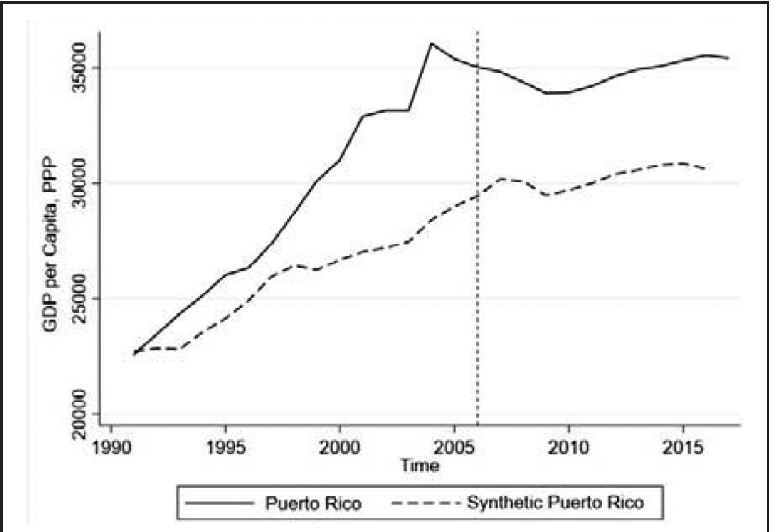
Path of GDP per Capita in Actual and Synthetic Puerto Rico.